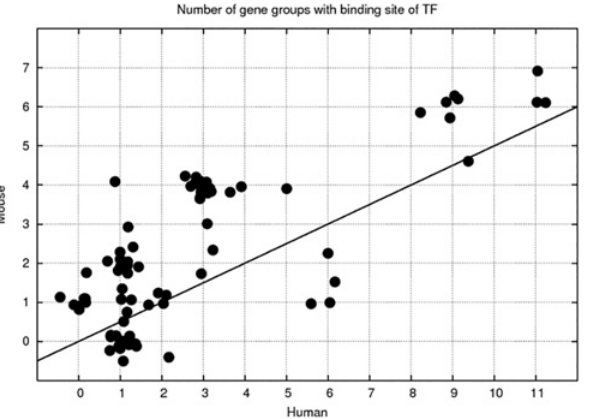
Fig 7. Number of gene groups with binding site of TF. Correlation between the number of gene groups/ clusters, having statistically significant overrepresentation of binding sites of 81 TFs, calculated for human and mouse clusters. The points are randomly disposed. The line y = 2 x is drawn for a